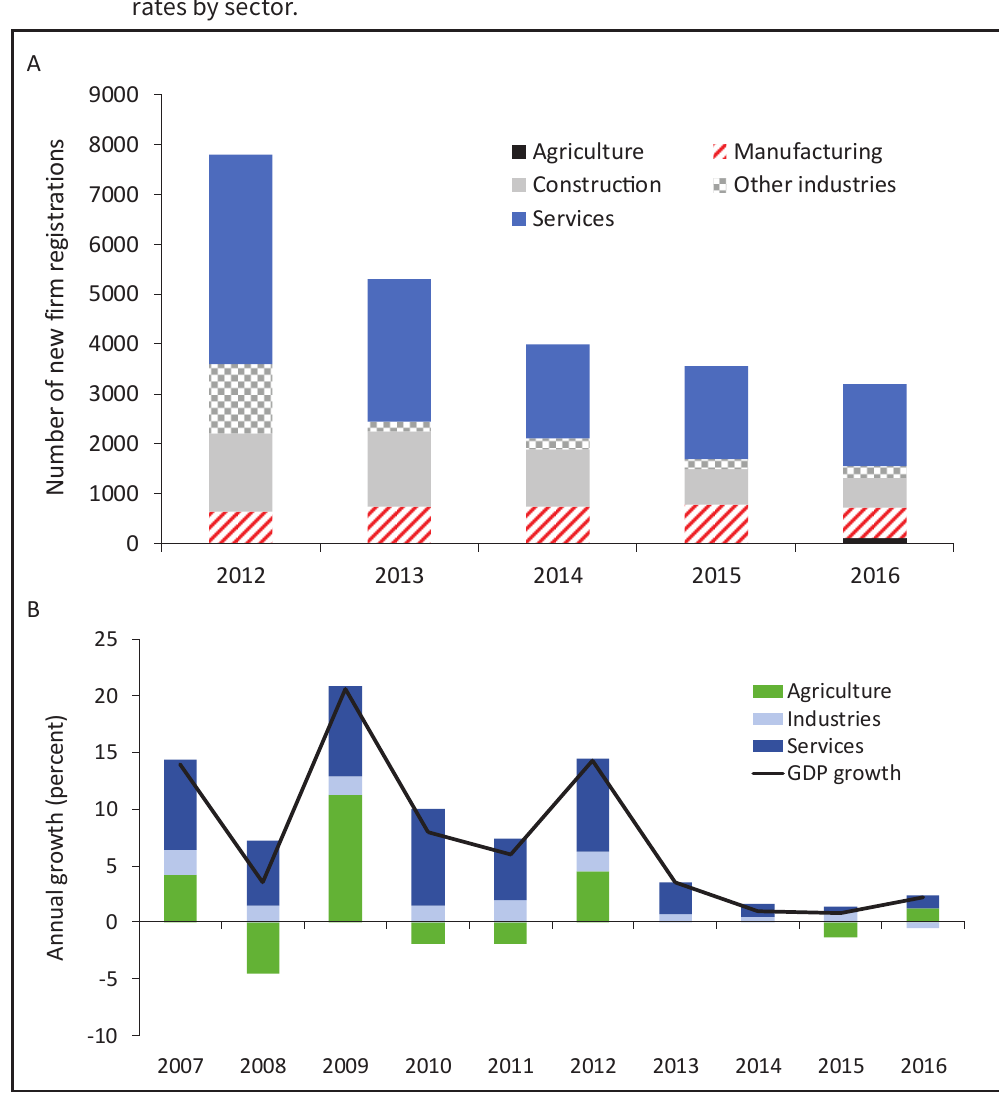
Figure 2 Economic activity in Afghanistan. (A) Firm registration by sector. (B) GDP growth rates by